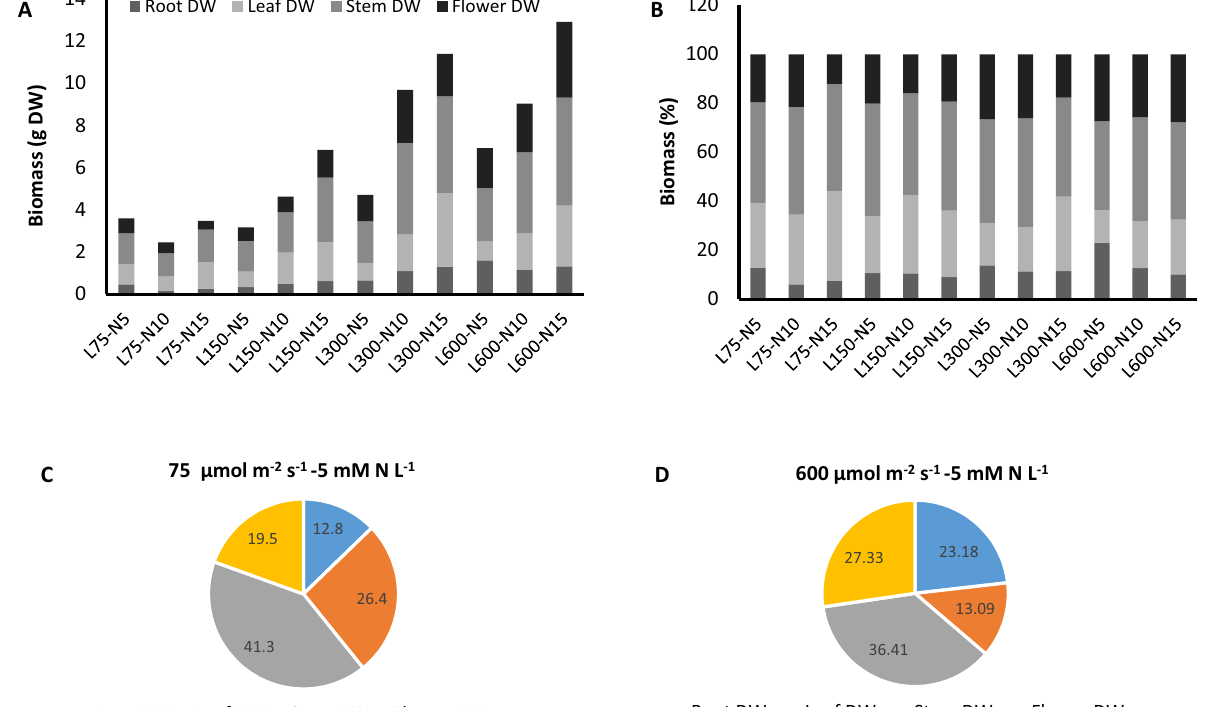
Figure 4. Total biomass ( A ), biomass partitioning among different organs ( B ), biomass partitioning among different organs in plants grown under 75 µmol m −2 s −1 and 5 mM N ( C ) and biomass partitioning among different organs in plants grown under 600 µmol m −2 s −1 and 5 mM N ( D ) of chrysanthemum grown under different light intensits (75, 150, 300, and 600 µmol m −2 s −1 ) and nitrogen (N) concentrations (5, 10, and 15 mM N) at 70 days of cultivation. Vertical bars are means ± SD. Within each graph, interactive effects of light intensity and nitrogen concentration are shown. Different letters (a–d) denote a significant difference between treaments (P <